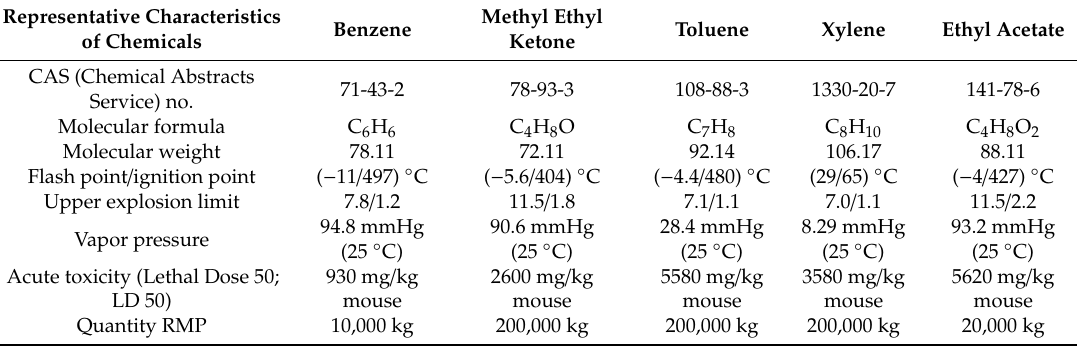
Table 1. Physicochemical properties of chemicals requiring preparation chemicals. RMP, risk management